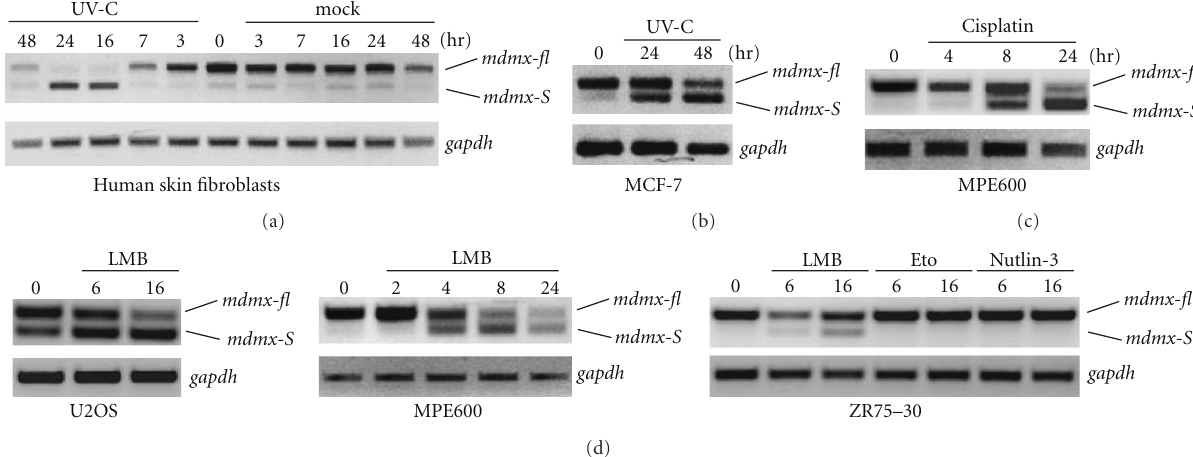
Figure 3: The ratio between mdmx-S and mdmx-fl mRNA is increased by various types of DNA damage and by inhibition of nuclear export. RT-PCR analysis of RNAs extracted from various cell lines, treated for the indicated time periods with a variety of agents. The mdmx - specific PCR primers are located in exon 3 and exon 8. The doses genotoxic/drug treatments used: UV-C: 15J/m 2 ; cisplatin: 30 μ M; LMB (Leptomycin B): 10nM; Eto (Etoposide): 20 μ M; Nutlin-3: 10 μ M.